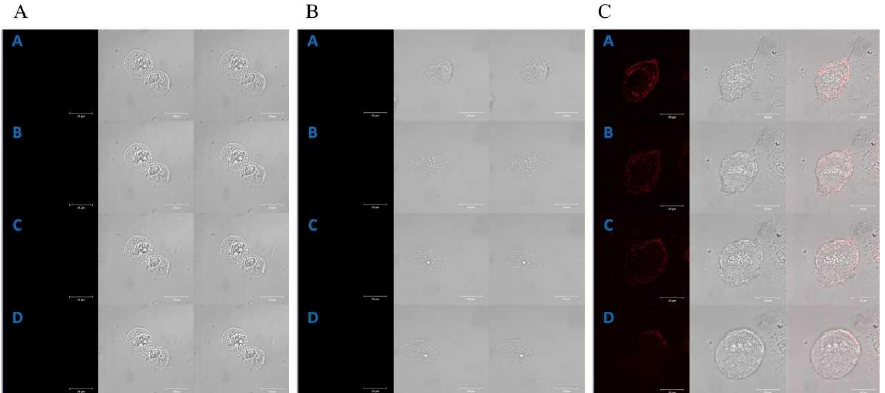
Figure 2. Control of the localization of porphyrins in the CCD 841 CoTr cells ( A ); selected images